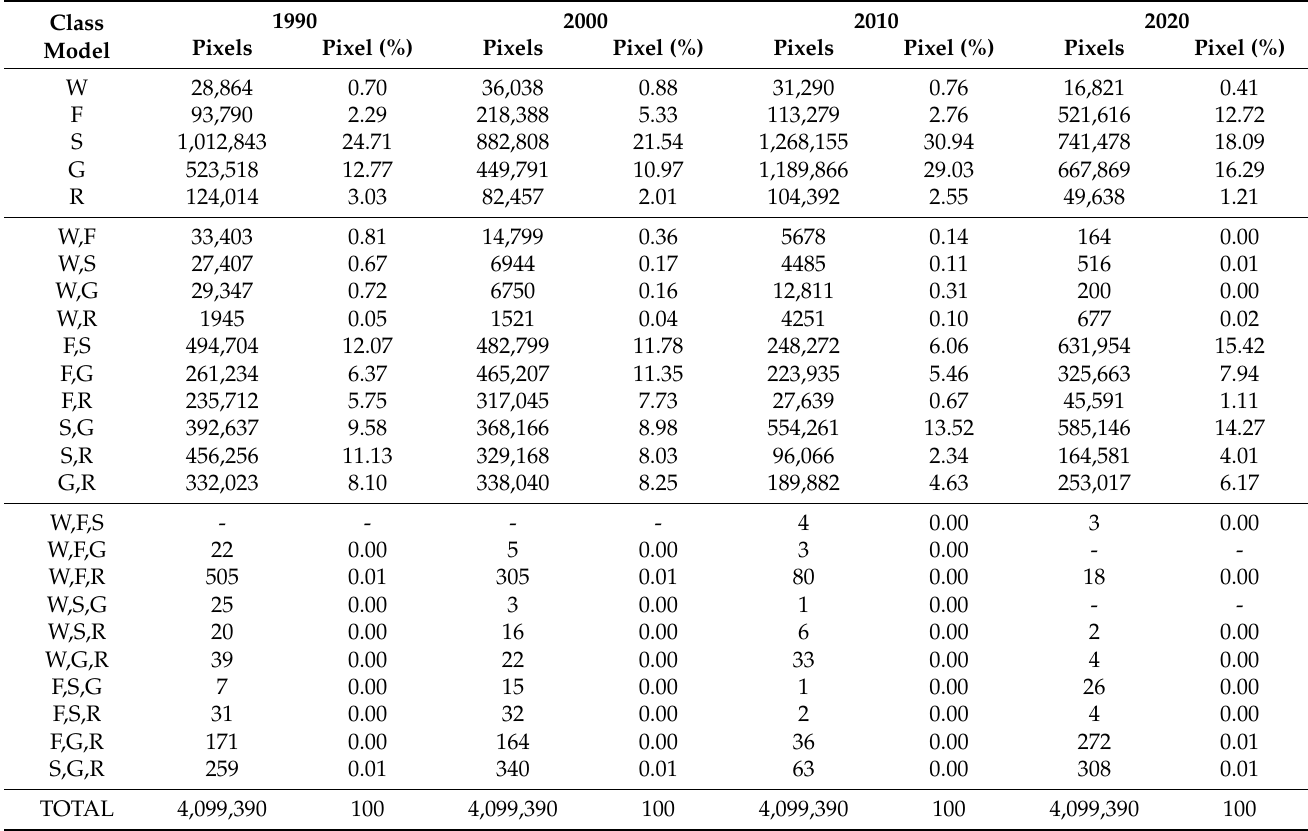
Table A1. Table of results obtained from the MESMA fraction images after normalization of the shade showing the number and proportion of pixels for each class model (W = water; F = forest; S = shrubland; G = grassland; R = rock and bare